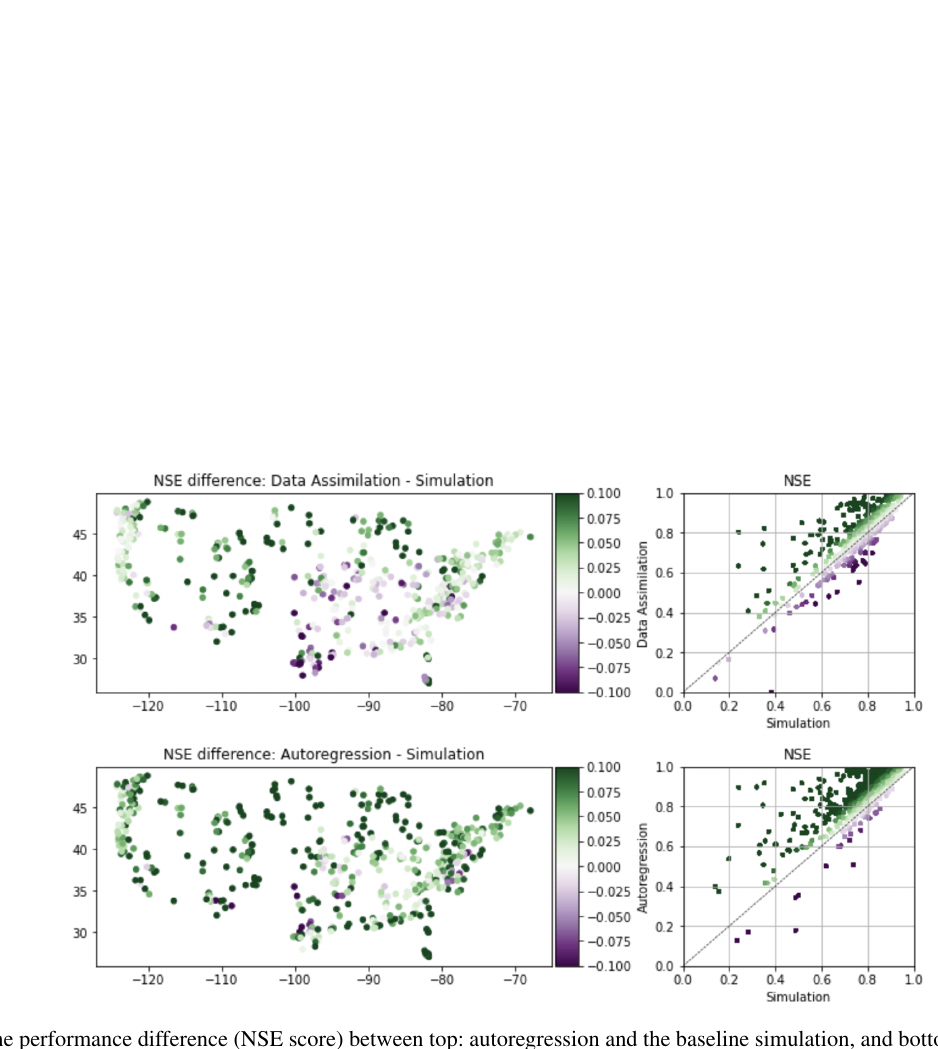
Figure G2. The performance difference (NSE score) between top: autoregression and the baseline simulation, and bottom: data assimilation and the baseline